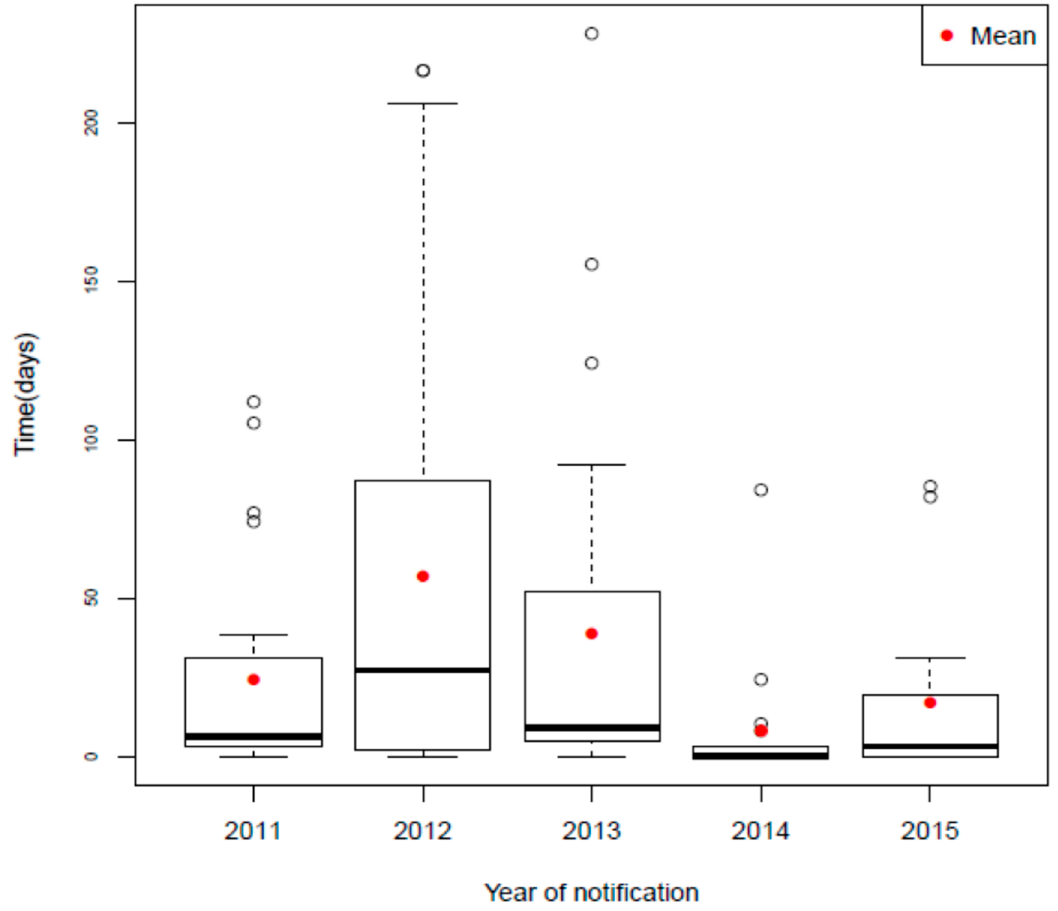
Figure 1. Time between diagnosis and notification of 129 cases of gestational syphilis in the municipality of Natal, Rio Grande do Norte, Brazil, from 2011 to 2015.